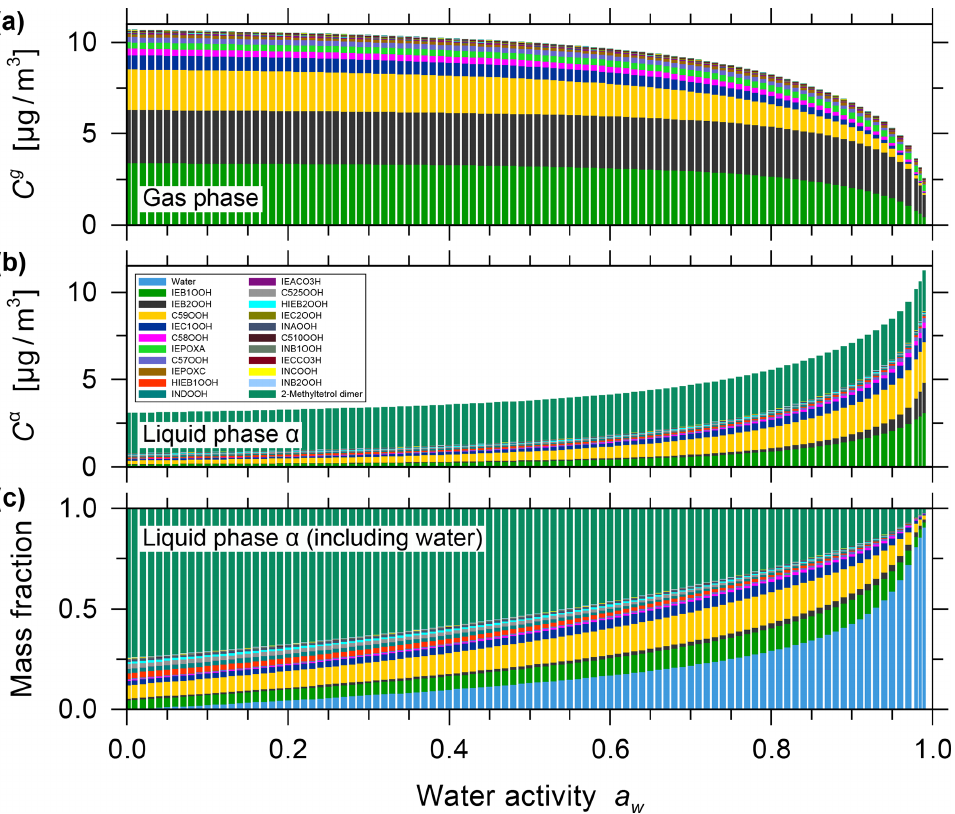
Figure 5. Predicted mass concentrations for (a) the gas phase and (b) the single liquid particle phase of the components (shown stacked; excluding water) for the isoprene photooxidation case using system components reported by Chen et al. (2011). (c) The mass fractions in the liquid phase, including water. All calculations are for 0.1% to 99% water activity (equilibrium RH) and a reacted isoprene concentration of 147µgm − 3 at 25 ◦ C for a seed-free